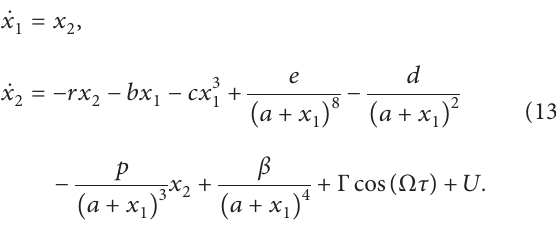
Figure 6: Bifurcation diagram for control gain κ